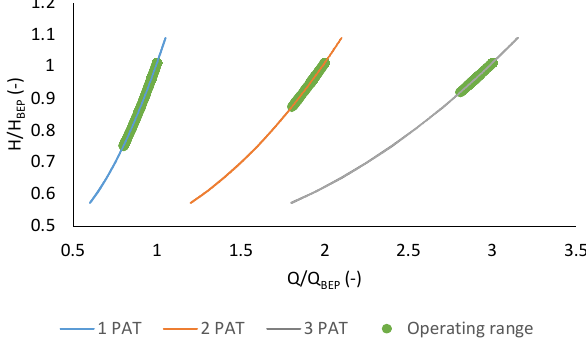
Figure 5. Dimensionless performance curves for one, two and three PAT running in parallel. Flow rate and head at the best efficiency point (Q BEP , H BEP ) are calculated by an optimization procedure for the three alternatives aiming at the maximization of the total recovered energy.